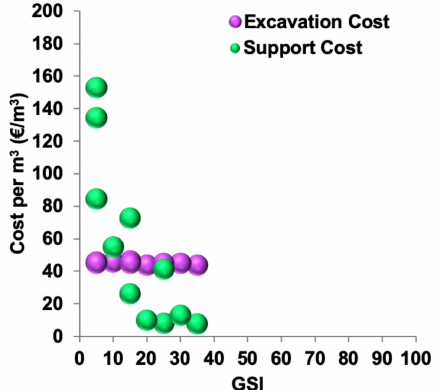
Figure 3. Tunnel construction cost per m 3 breaking down the excavation cost and temporary support cost vs. the Geological Strength Index (GSI) values (2011 price level), (modified from